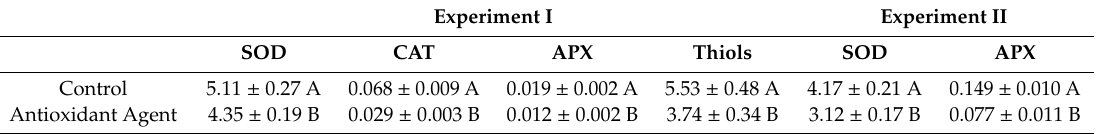
Table 12. Superoxide dismutase activity (SOD unit mg protein − 1 ), catalase activity (mmol mg